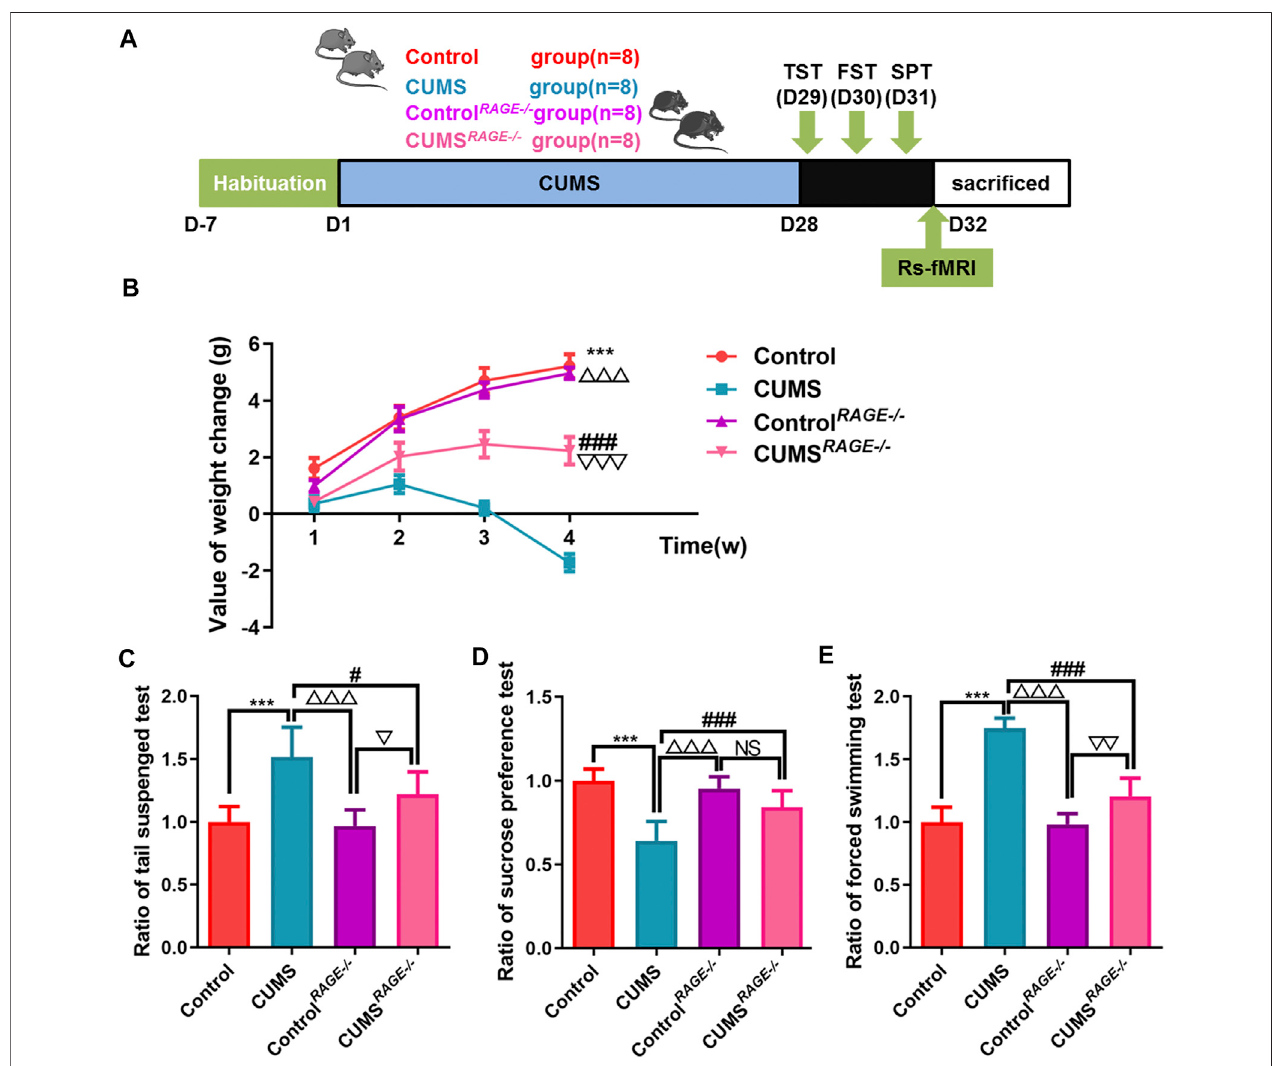
FIGURE 3 | Effect of RAGE gene knockout on the behavior of depressive-like mice induced by chronic stress. (A) Schematic overview of experimental approach and time line. (B) The value of body weight changes in mice. (C – E) Mice behavioral tests. (C) Tail suspension test (TST); (D) sucrose preference test (SPT); and (E) force swimmingtest(FST).One-wayANOVAfollowedbyBonferroni ’ s posthoc test;*** p < 0.001,CUMSgroupvs.Controlgroup; # p < 0.05and ### p < 0.001,CUMSgroupvs. CUMS RAGE − / − group; △△△ p < 0.001, CUMS group vs. Control RAGE − / − group; error bars indicate mean ± SEM.